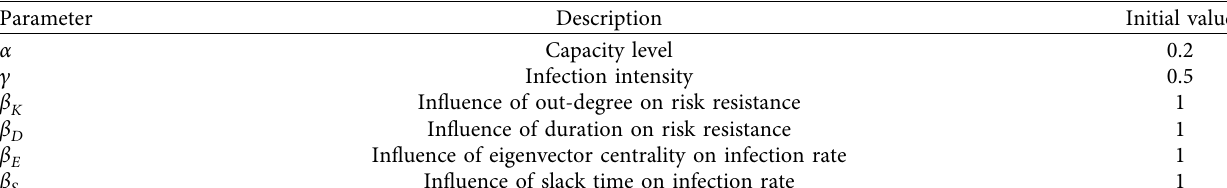
Table 2: Initial values of parameters.